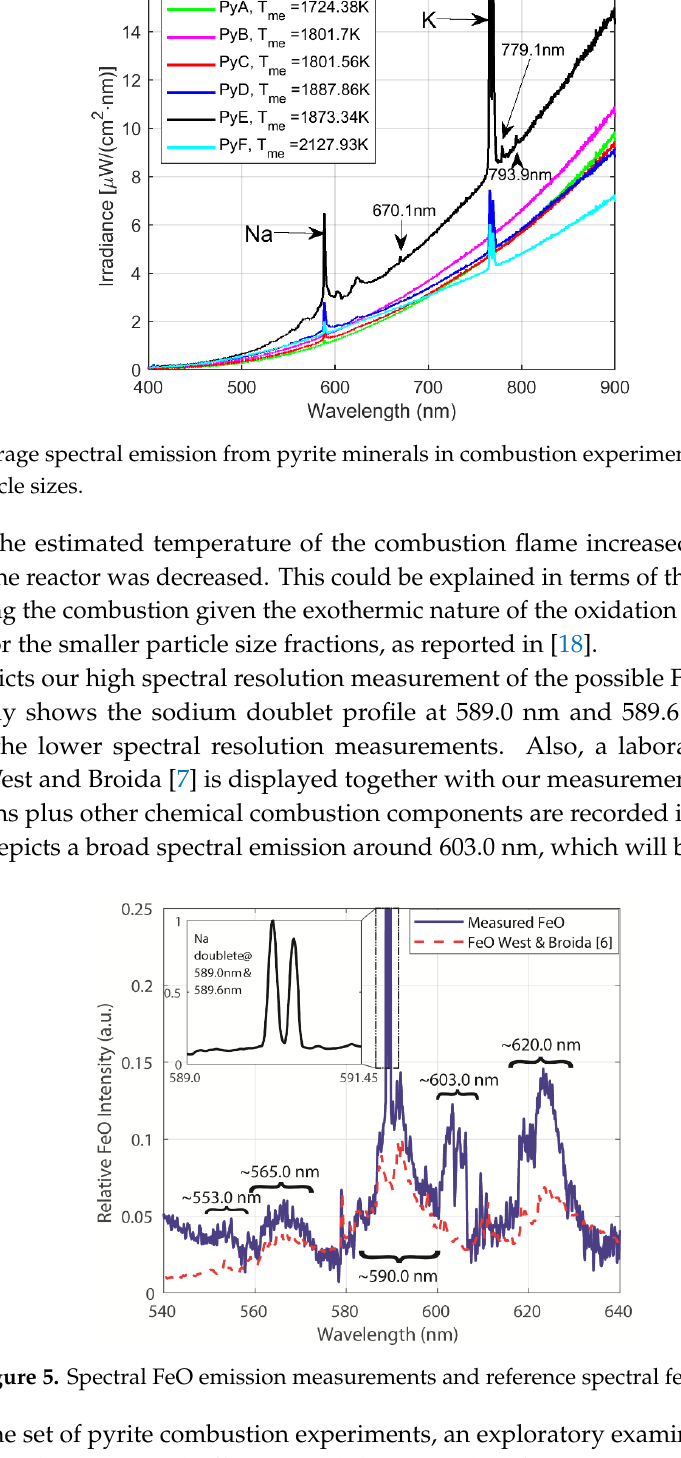
Figure 6. Extraction of spectral features with PCA from pyrite combustion for different particle sizes, P.V. 1 (loadings vectors) are depicted. Then, the MCR-ALS method was applied to the combustion experiment spectrum with the highest, in intensity, emission profile. In this case, spectra from the sample PyE were selected. The main settings selected for the MCR-ALS GUI were: the number of components to estimate, assessed with the SVD algorithm according to estimated eigenvalues, was 8. From an exploratory analysis,